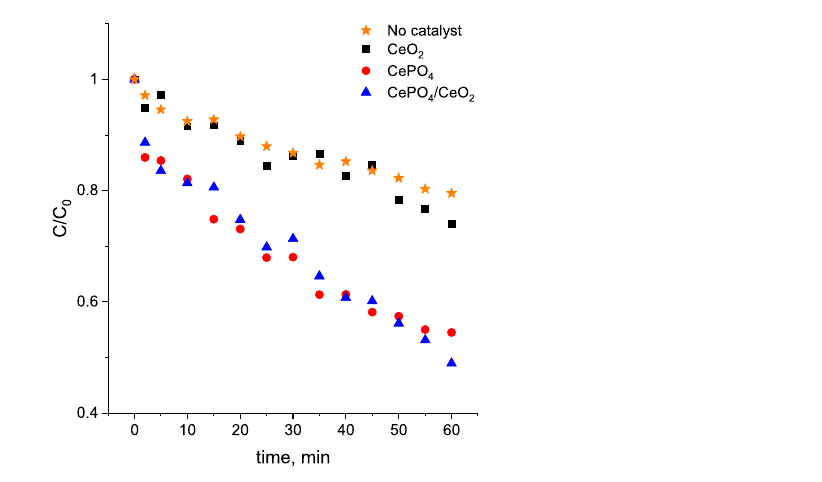
Figure 8. Efficiency of ozone decomposition in the presence of the catalysts. Reaction conditions: initial ozone concentration: 120 µM, initial pH: 2.5, catalyst loading: 0.2 g/L, room temperature. Reactions conducted without BA and chloride ions in the